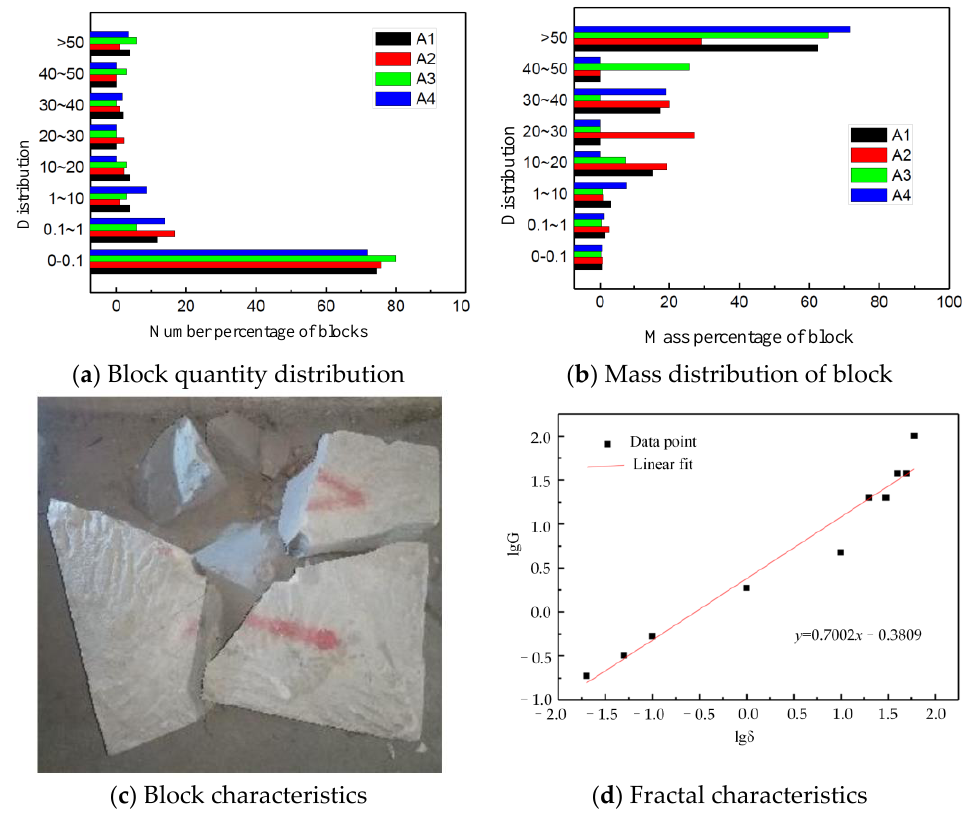
Figure 16. Block distribution and fractal characteristics of CDPTB sample [40].